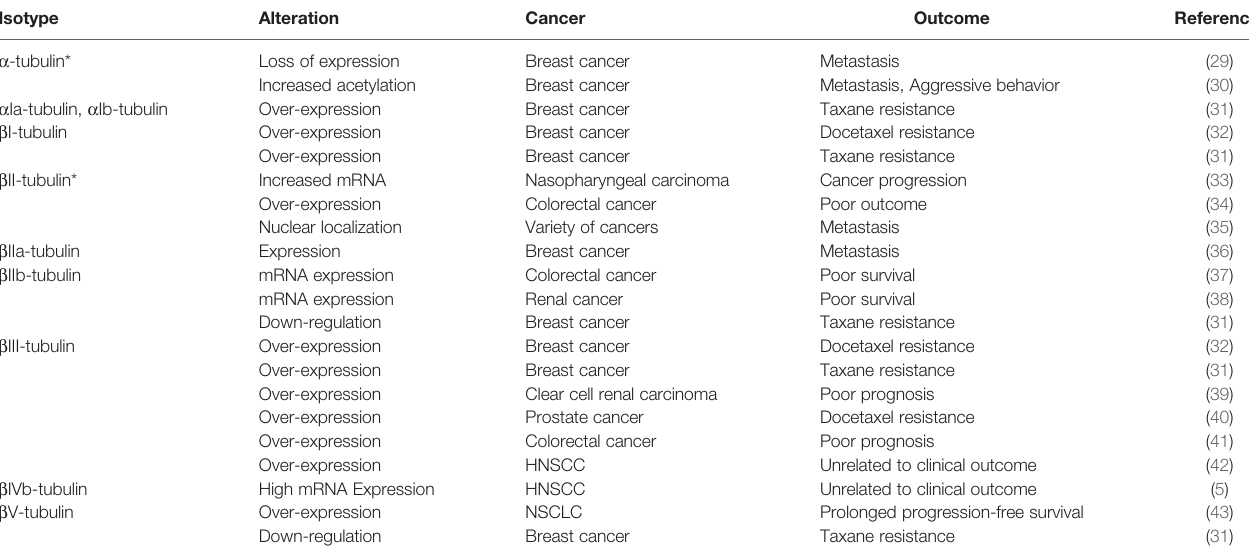
TABLE 1 | Tubulin deregulation in cancer.